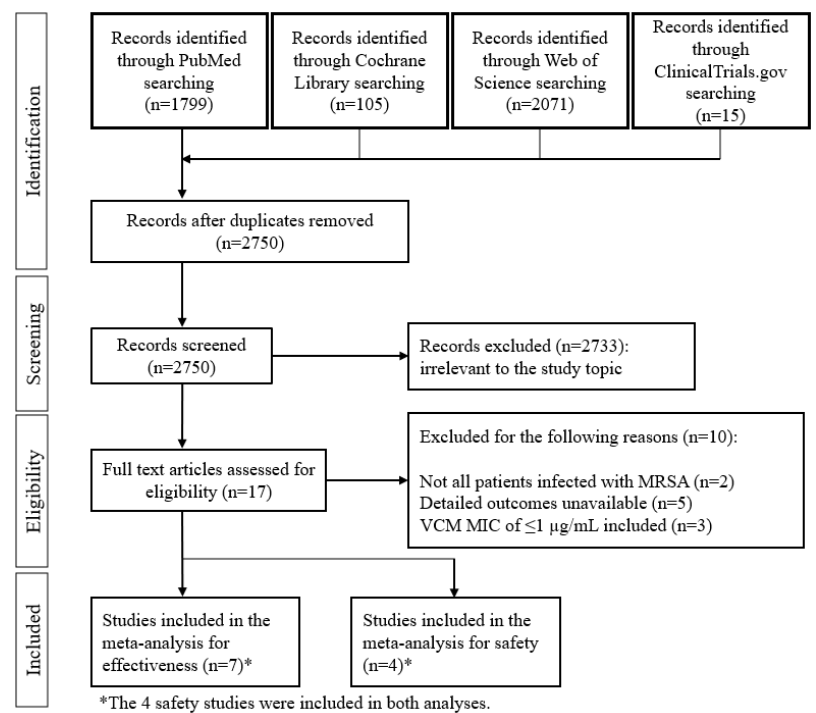
Figure 1. Flow chart of the study selection process.